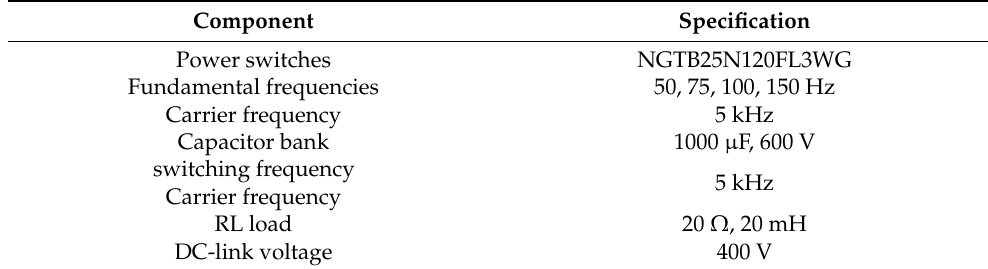
Table 3. Prototype